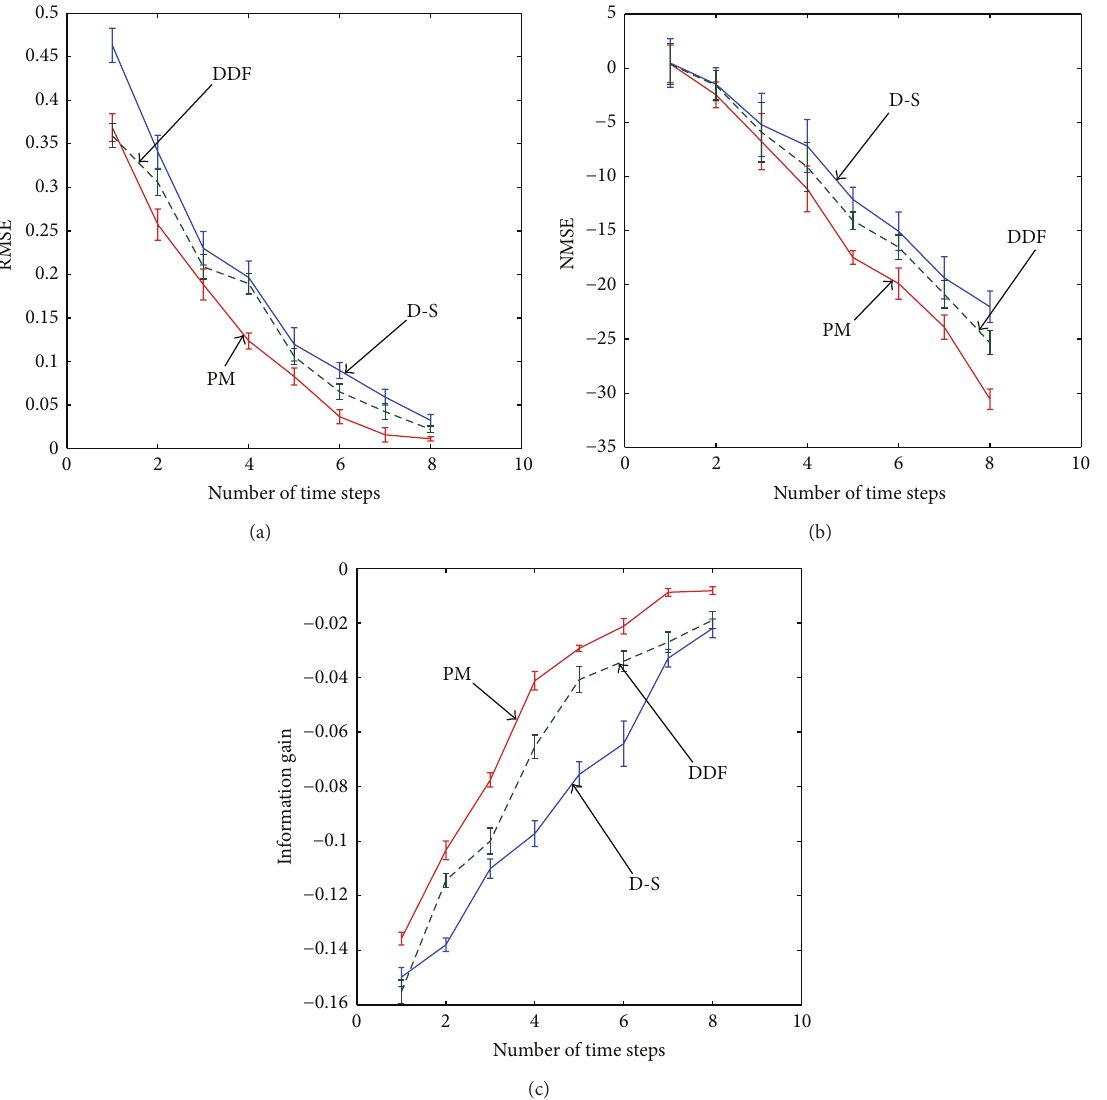
Figure 14: Comparsion between our prediction market-based information aggregation and Dempster-Shafer theory based fusion (DS) and distributed fata fusion (DDF); (a) root mean square error; (b) normalized root mean square error; and (c) information gain. The results show that, over time, the PM-based technique is able to perform better than the compared